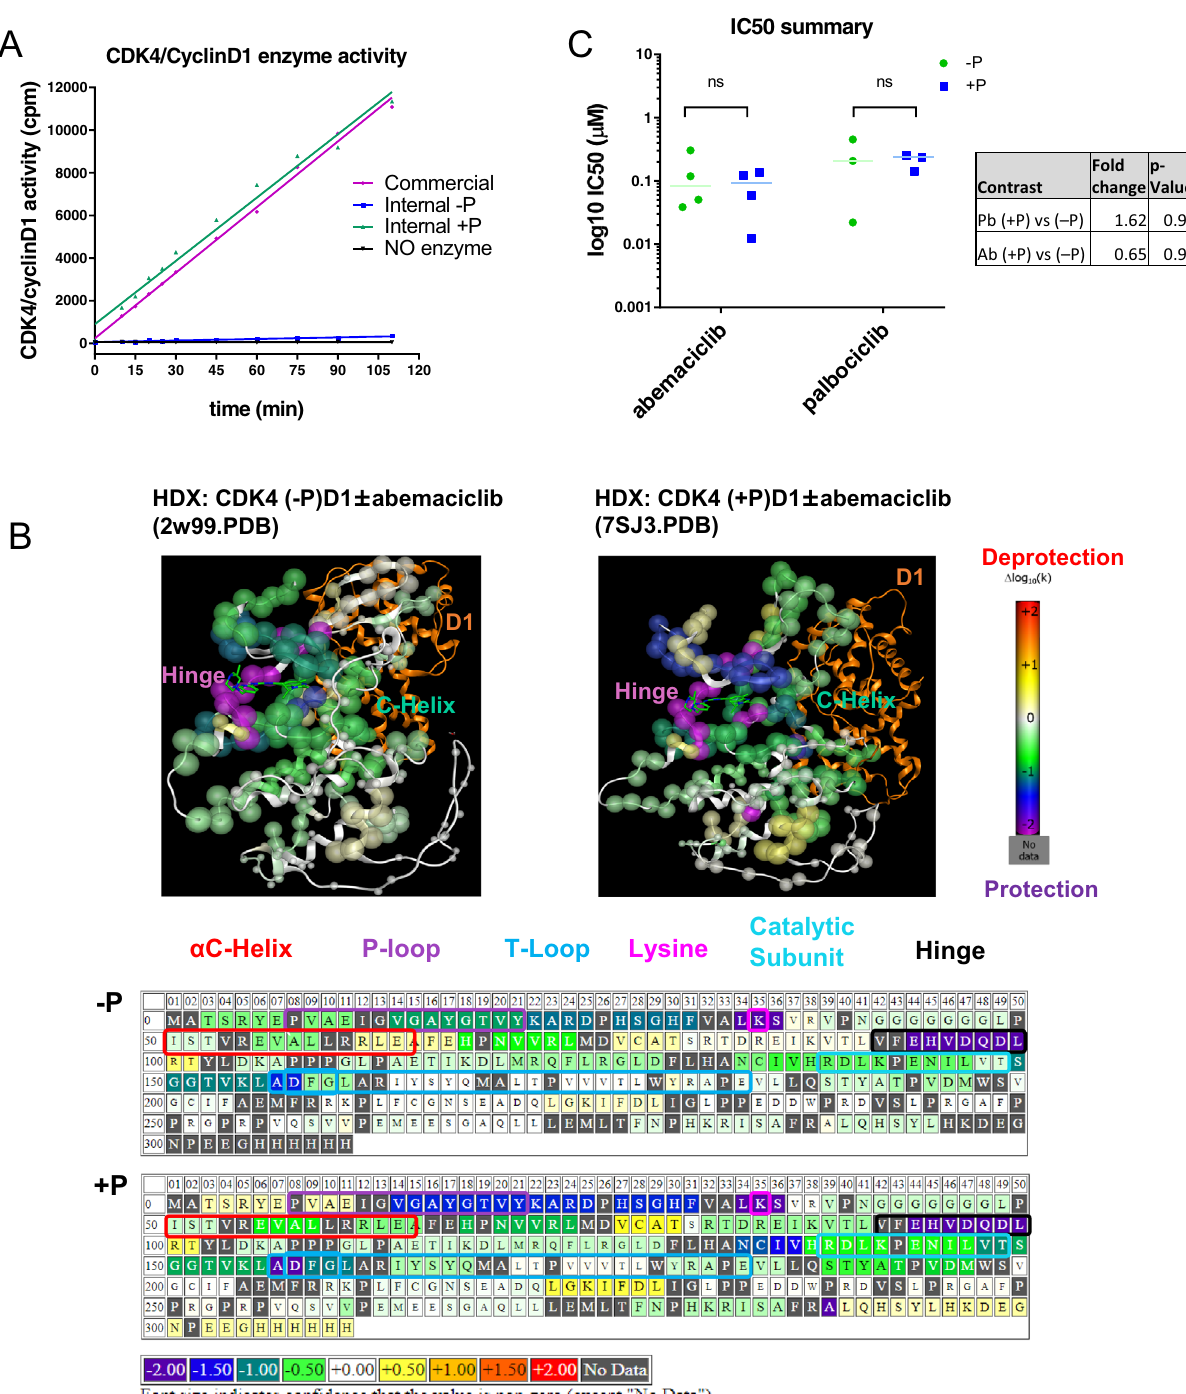
Fig. 2 CDK4/6 inhibitor binds CDK4 regardless of T172 phosphorylation. A In vitro kinase activity assay: [ γ - 33 P] ATP phosphorylation of CTRF using phosphorylated and unphosphorylated CDK4-cyclin D dimer. B (Top) HDX log10(k) projection (left panel (-P), 2W99.pdb) and phosphorylated (right panel ( + P), 7SJ3.pdb) and (Bottom) differential HDX map of unphosphorylated (upper) and phosphorylated (lower) CDK4-cyclin D1 dimer and abemaciclib. The panels show the difference between the calculated log10 rate constants for the ligand-bound state and the Apo states (colors). Size of font/sphere provides an approximate indication of con fi dence that the value of the HDX perturbation is not zero; font color is chosen only for optimum contrast with the background. C in vitro target engagement assay with ATP/ADP desthiobiotin probes to measure abemaciclib (Ab) or palbociclib (Pb) af fi nity to unphosphorylated (-P) and phosphorylated ( + P) CDK4-cyclin D recombinant proteins. ns – not signi fi cant. P-values determined by pairwise t-test. Error bars represent ± standard